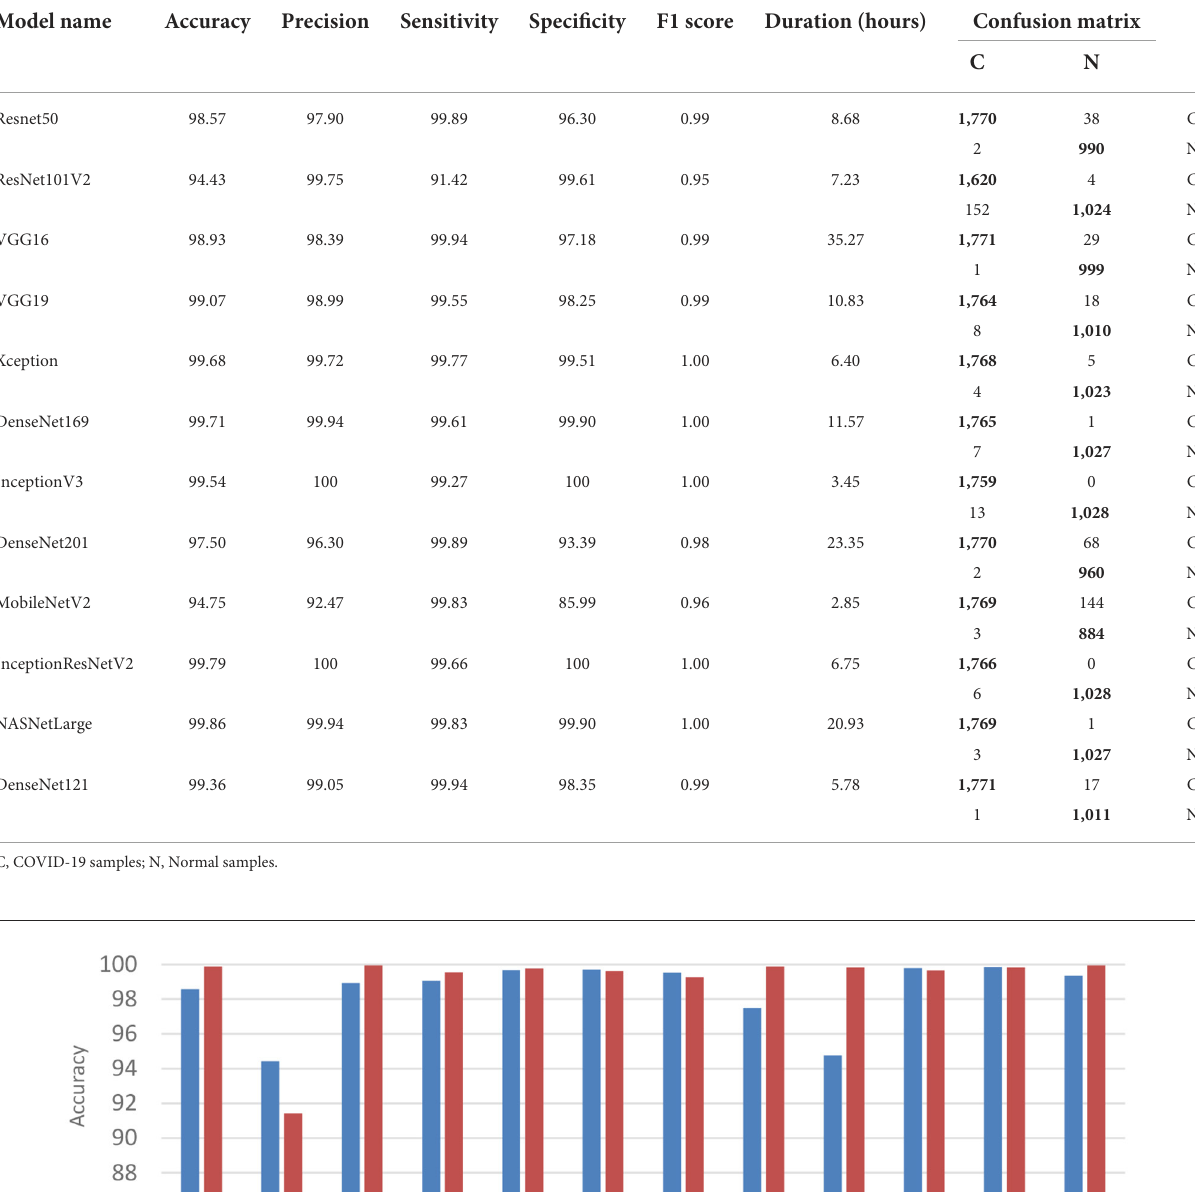
TABLE 7 Results after data augmentation.